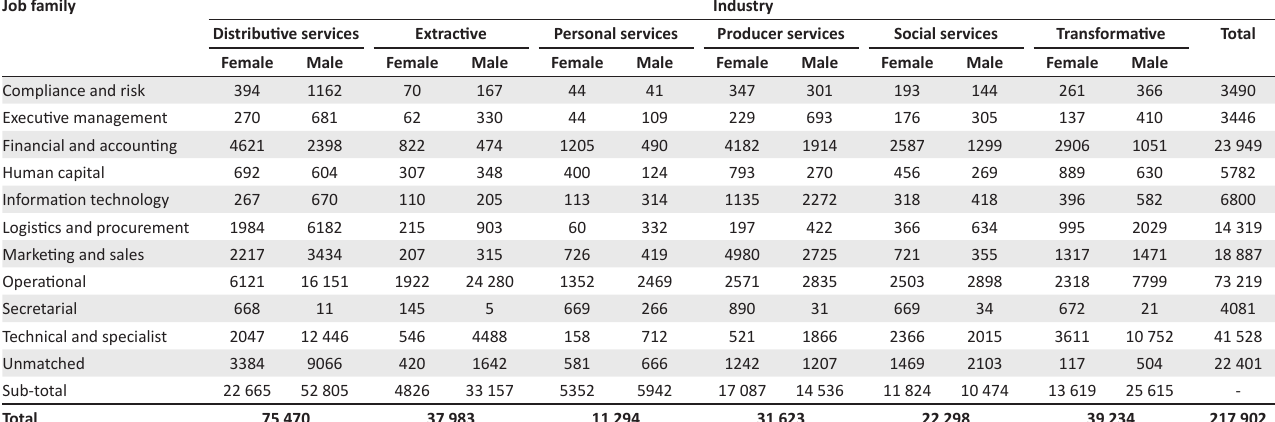
TABLE 2: Population frequency by gender, job family and